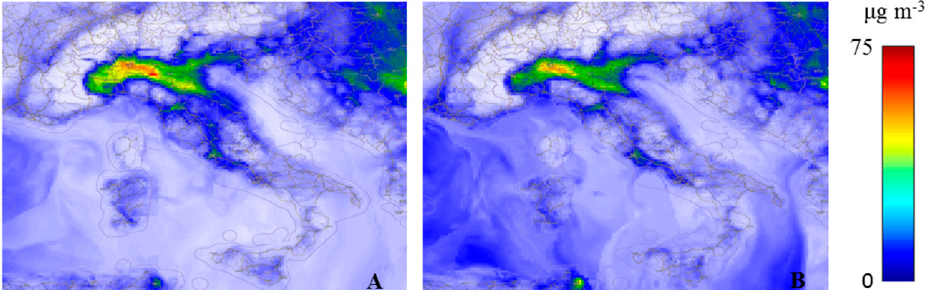
Figure 2. PM 2.5 ( A ) and PM 10 ( B ) concentration levels at 00:00 Coordinated Universal Time (UTC) on 16 February 2020 from near-real-time ECMWF–CAMS analysis over an area extending over the latitudinal interval 36–48 ◦ N and the longitudinal interval 5–20 ◦